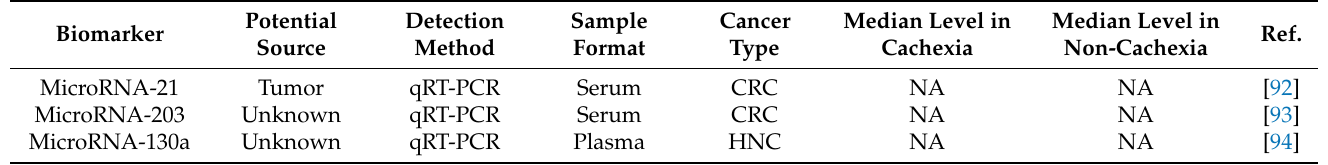
Table 4. Summary of microRNAs as potential biomarkers of cancer